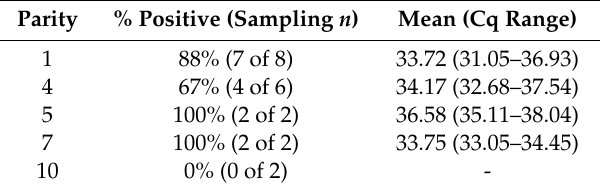
Table 2. DistributionofdetectionofPoAstV3infecalsamplesofsowsacrossdifferentparitiesbyRT-qPCR.